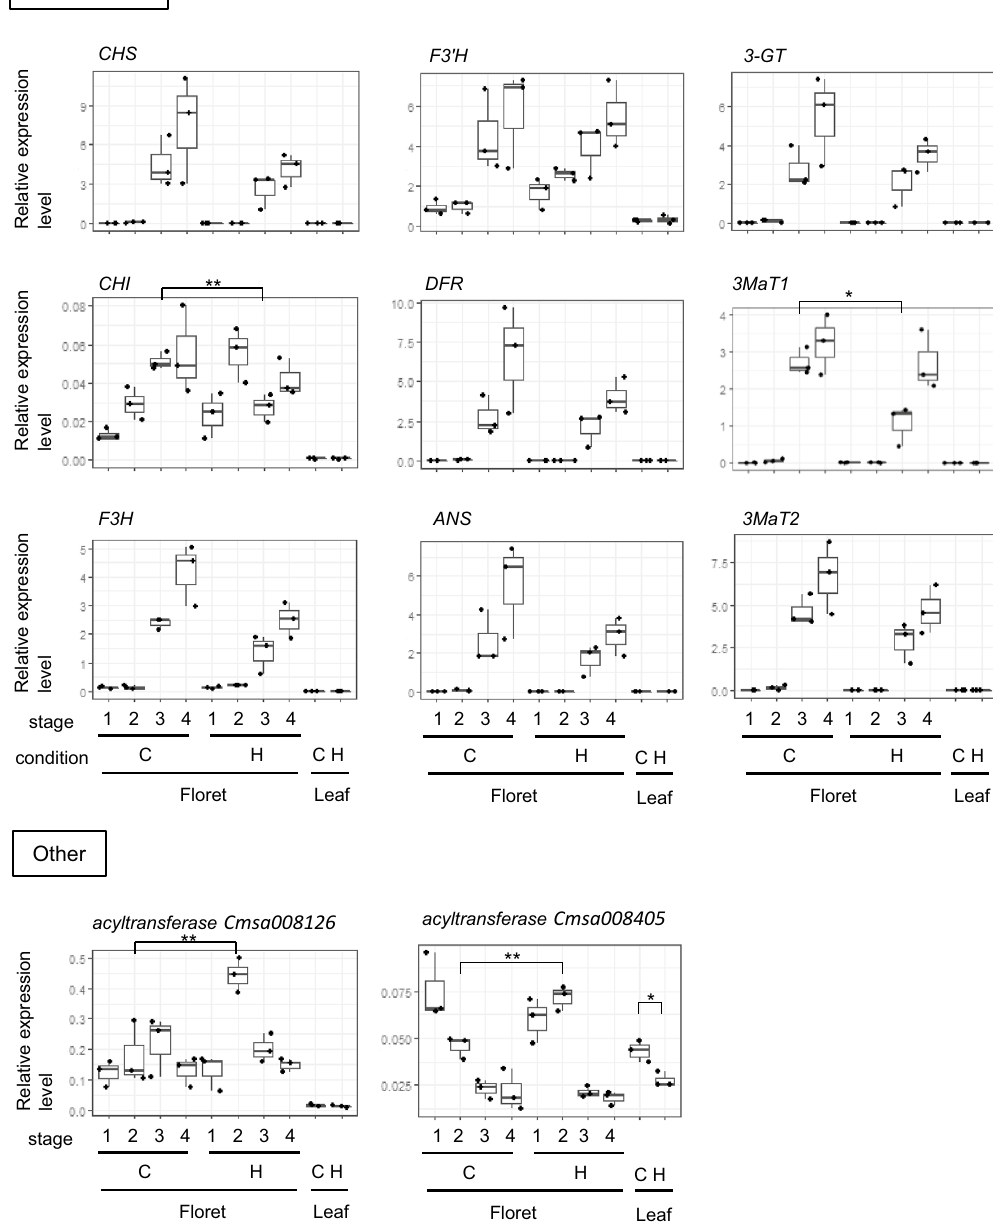
Figure 5. Changes in expression of anthocyanin biosynthesis gene orthologs as indicators of dataset quality. Changes in the expression of the anthocyanin biosynthesis gene orthologs determined by qRT-PCR. qRT-PCR was performed to evaluate the expression of CHS , CHI , F3H , F3 ′ H , DFR , ANS , and 3-GT orthologs, 3MaT1 and 3MaT2 . Two acyltransferase genes were analyzed as controls for other metabolite pathways. The vertical bar indicates the relative expression level using Cmsa000988 as reference. Each point indicated a relative expression level. The bold bar indicates the mean of three biological replicates. Student two-sample t-test was performed between control and high nighttime temperatures at the same growth stages. *p-value < 0.05. **p-value < 0.01. H: samples cultured at 25 °C/25 °C (high nighttime temperature). C: samples cultured at 25 °C/15 °C (control condition). The growth stages of the ray-floret samples are indicated in Fig.